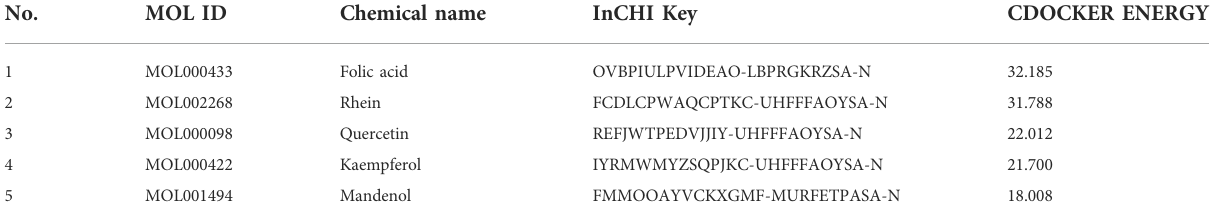
TABLE 2 Top fi ve ingredients scored after docking 3AA1 molecules with 33 compounds. No. MOL